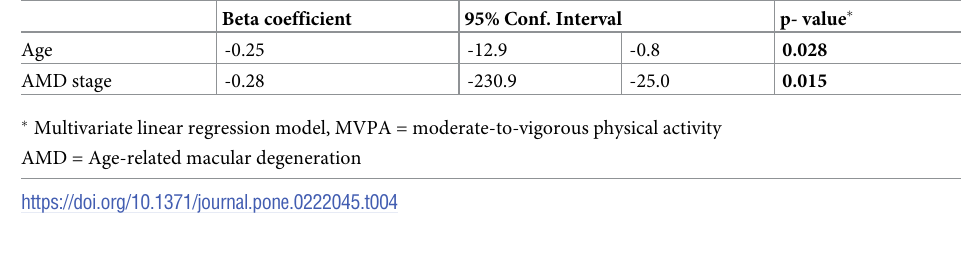
Table 4. Determinants of MVPA including AMD